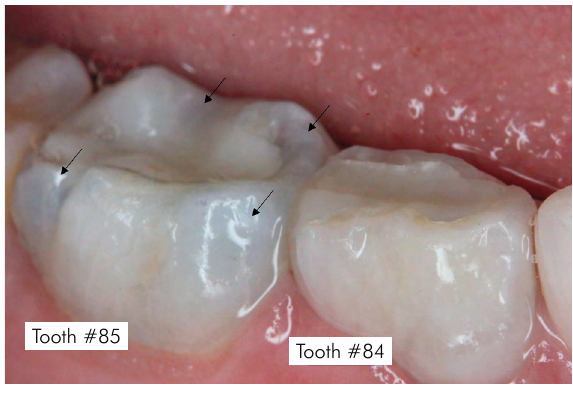
Figure 2. Example of non-discoloration of tooth #84 (1 st lower molar) with Bio-C Pulpo medicament after pulpotomy, unlike tooth #85 (2 nd lower molar) with MTA Angelus medicament, showing black dots on the dental crown after the six-month follow-up, indicated by the